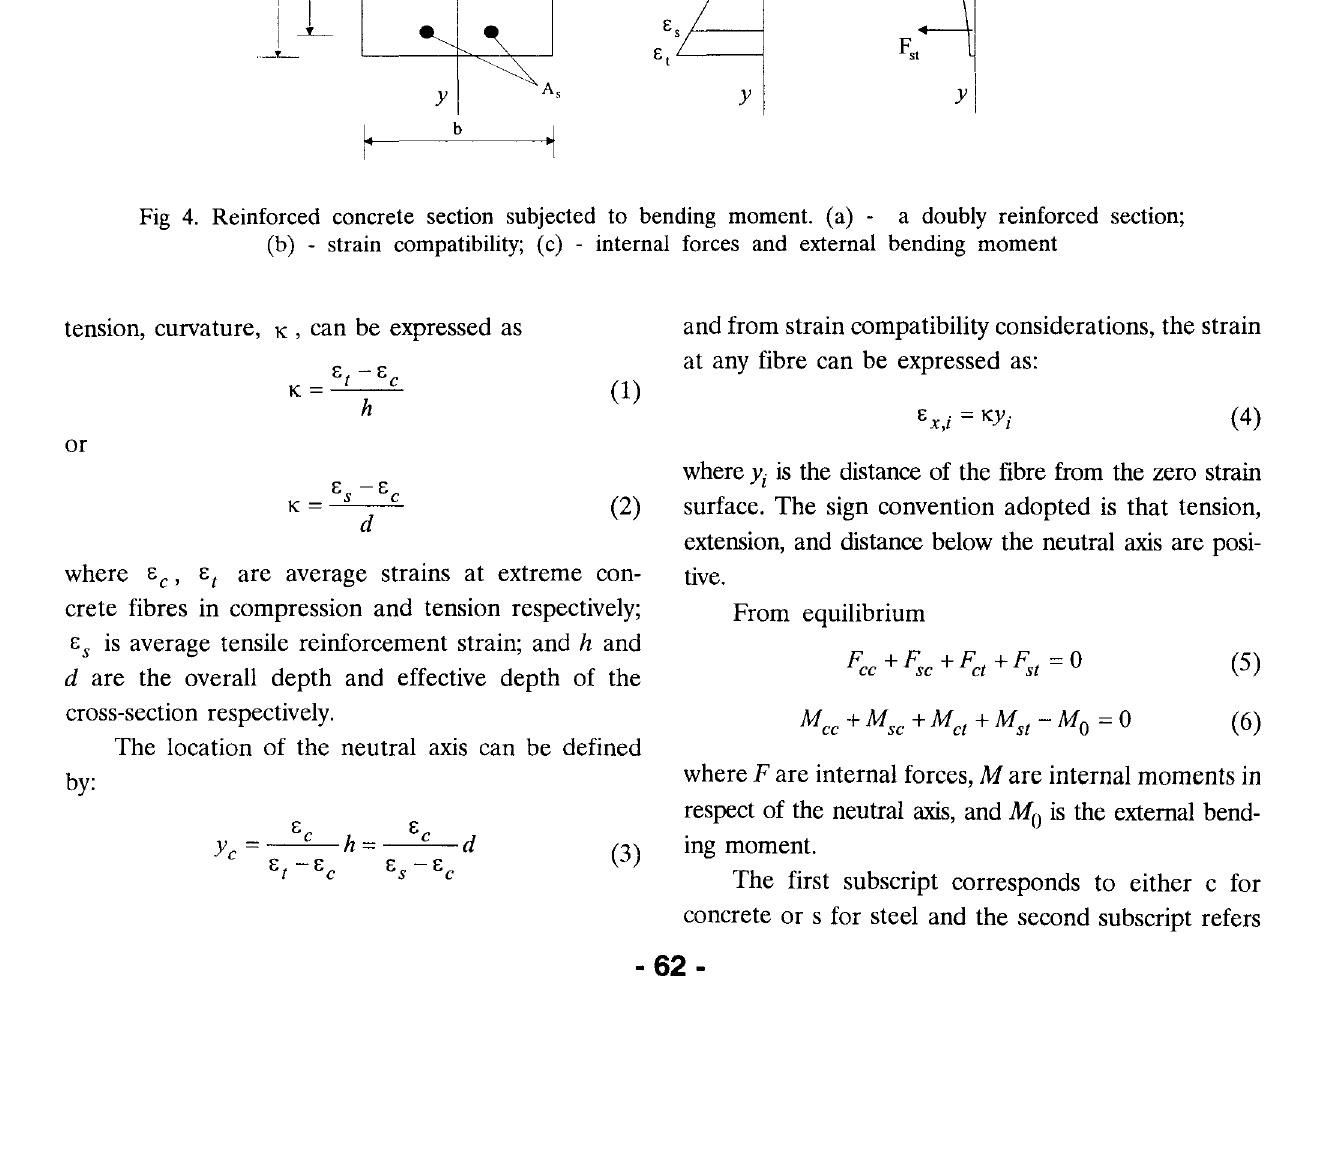
Fig 3. Average stress-strain relation for concrete in tension for different layers of a cross-section